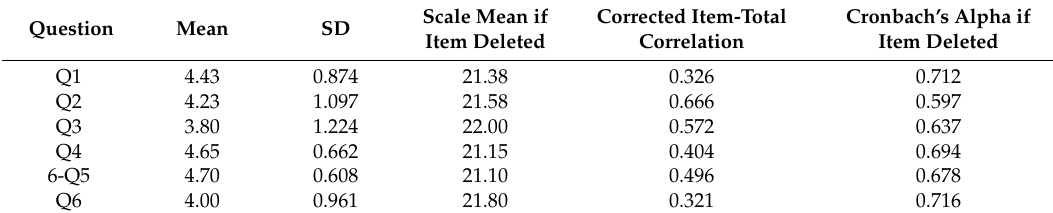
Table 3. Score on questions of the USEQ. Corrected Item-Total Correlation. Cronbach’s Alpha if item is